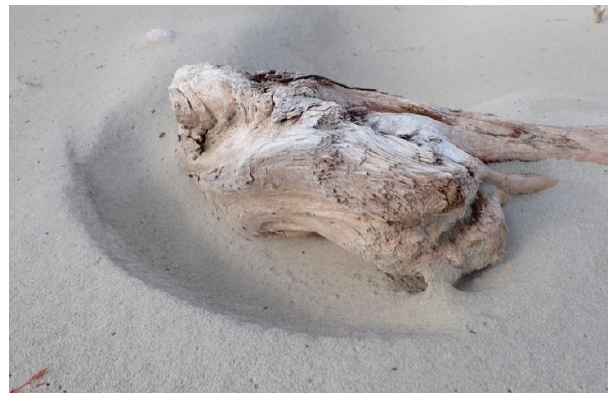
Figure 3. Typical scour pattern due to horseshoe vortex around a piece of isolated LWD. Deflation hole is approximately 2 m in diameter. (photo credit: M. Grilliot).